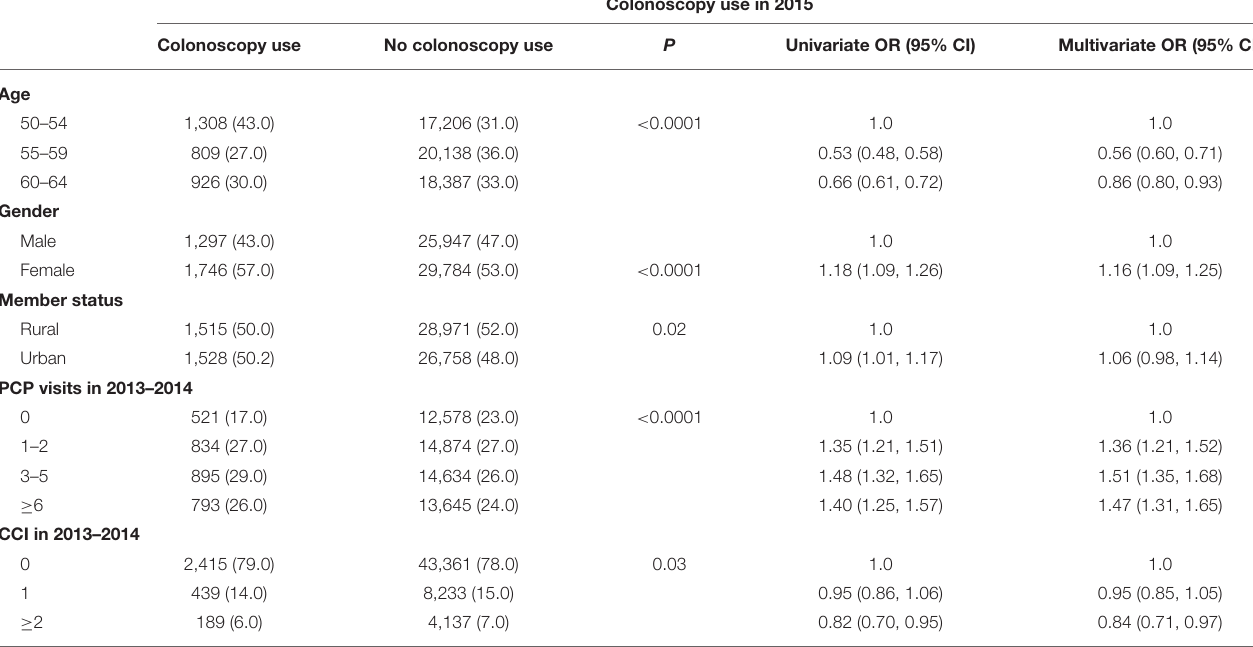
TABLE 4 | Univariate and multivariate analyses of variables associated with the use of colonoscopy using logistic regression models, BCBSNE